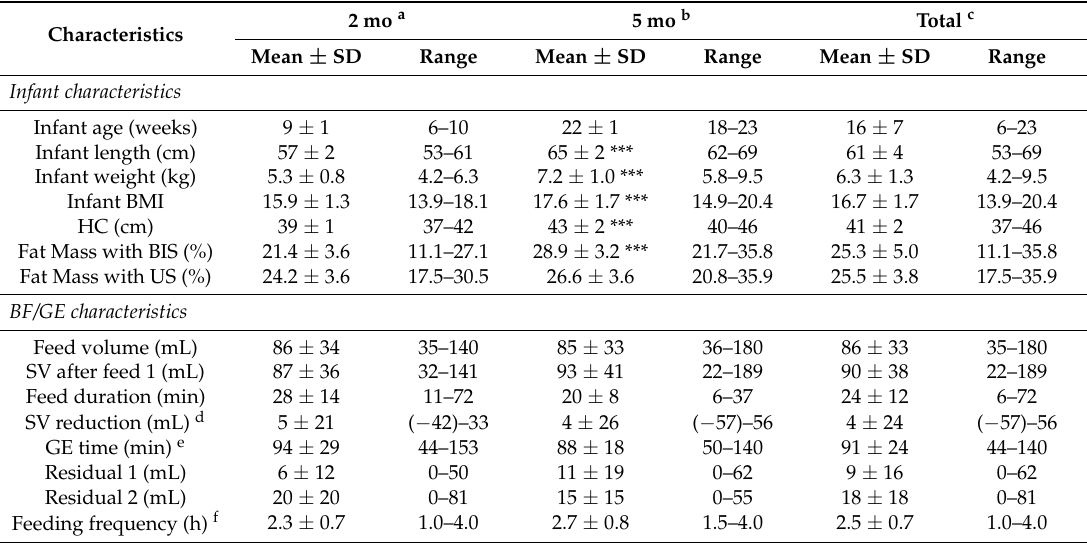
Table 1. Participant characteristics expressed as mean ± SD and range.